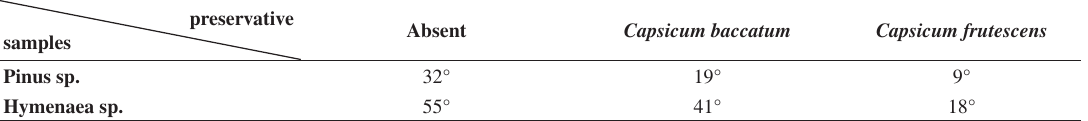
Table 1. Contact angles for wood samples without and with preservative treatment*. preservative samples